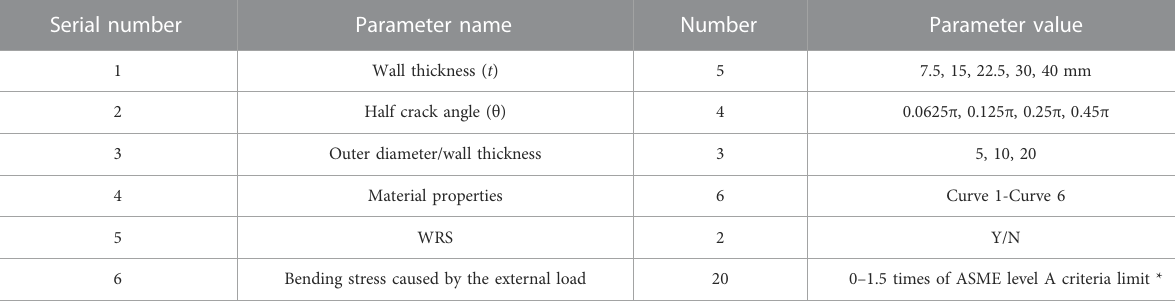
TABLE 3 Input parameters of the fi nite element analysis